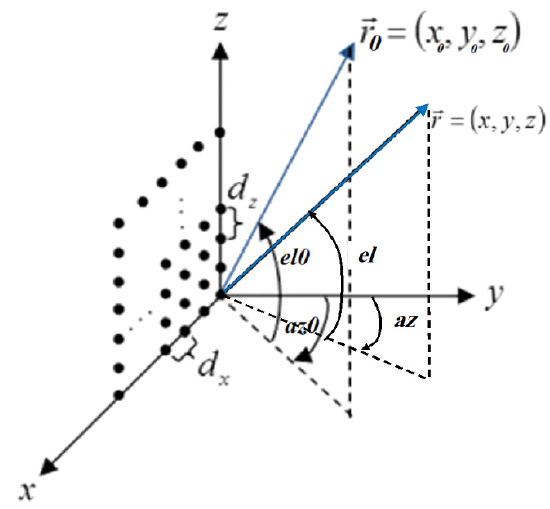
Figure 1. Element Array in the X–Z plane.